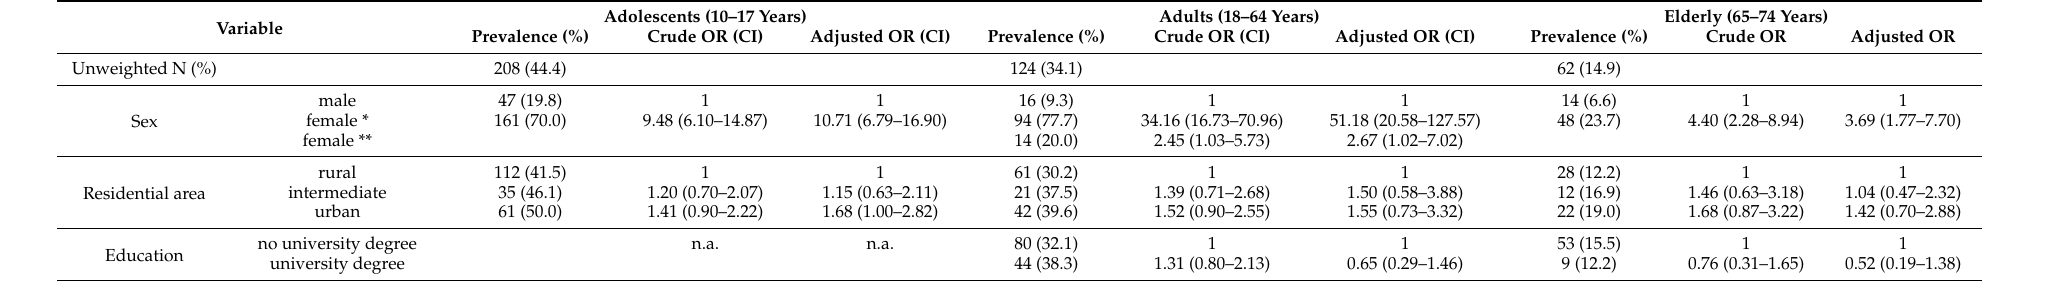
Table 2. Association between the prevalence of inadequate daily dietary iron intake and different sociodemographic and behavioural